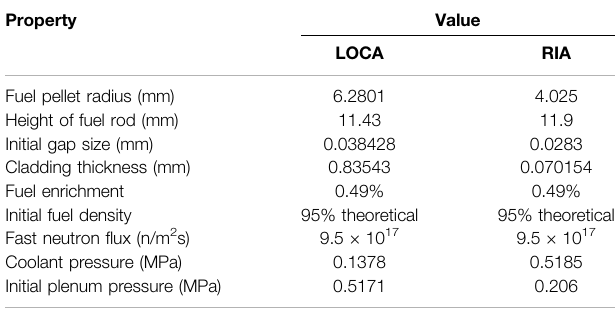
TABLE 1 | Model speci fi cations. Property Value